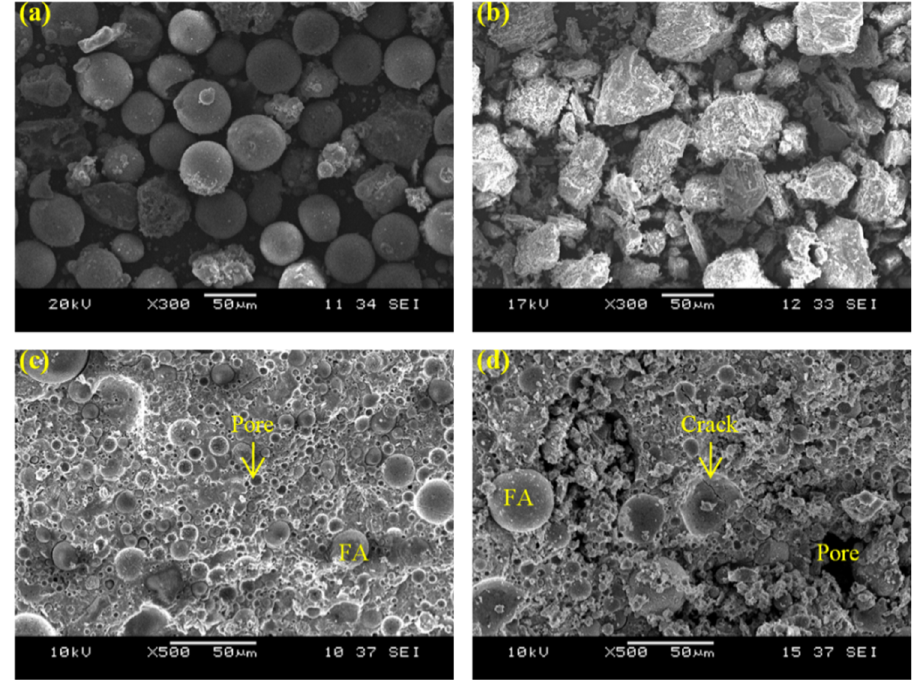
Figure 10. SEM images of ( a ) fly ash, ( b ) slag, unheated ( c ) G-0 and ( d ) G-2 (FA denoted fly